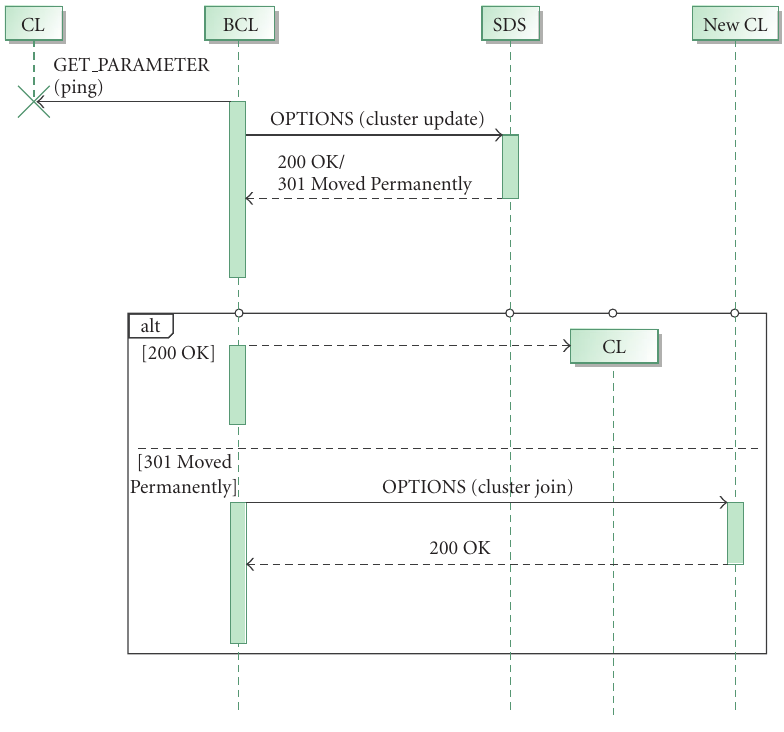
Figure 3: Uncontrolled CL